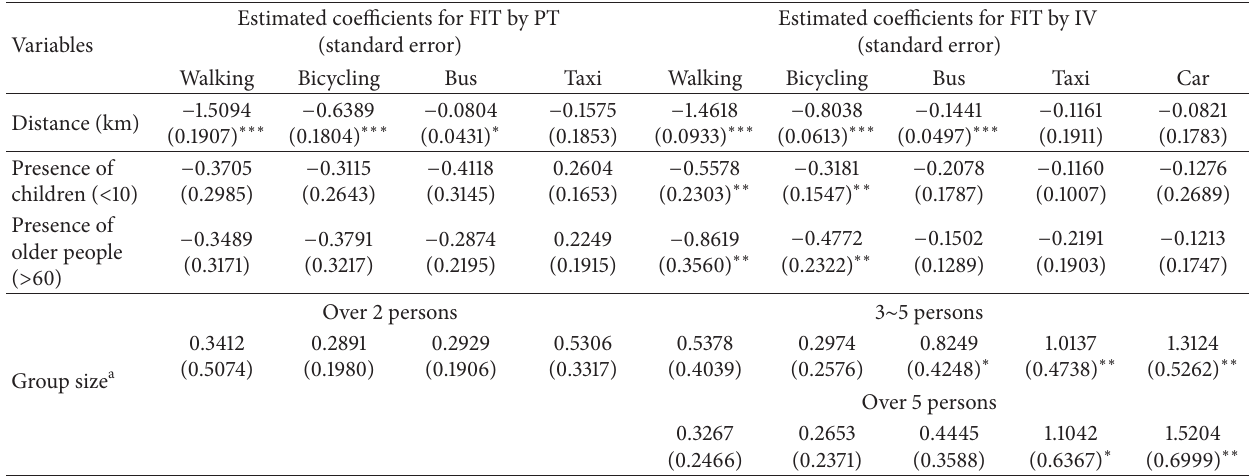
Table 7: Estimated coefficients of public variables for each transport